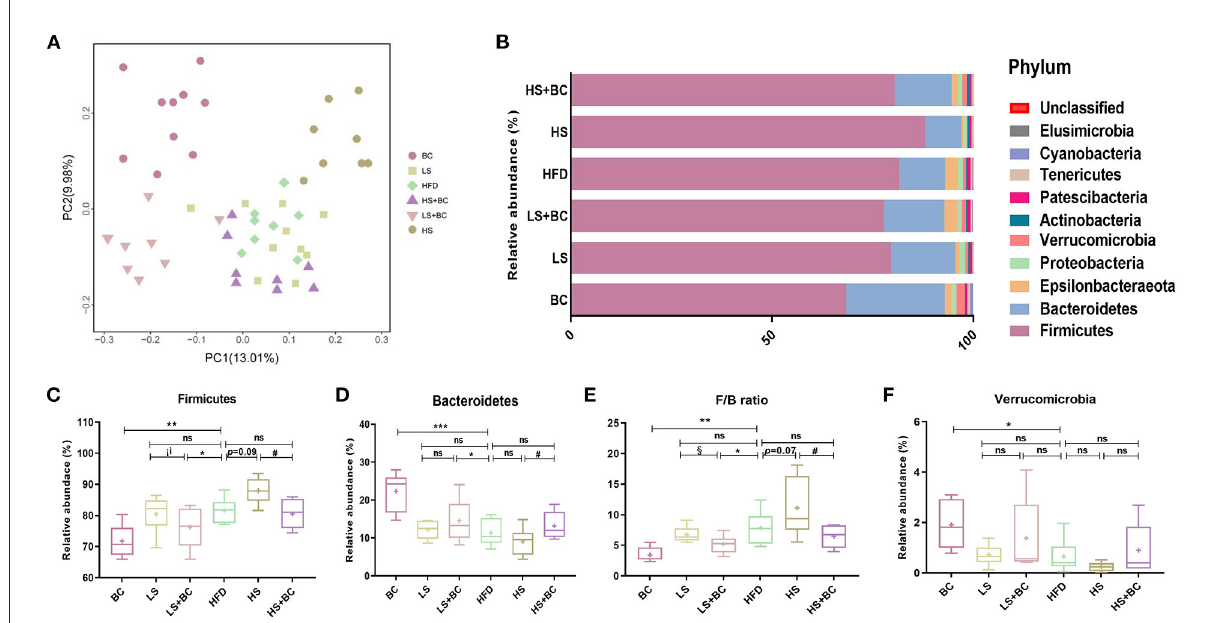
FIGURE2 Effect of BCPs treatment on gut microbiota structure of phylum level in HFD-induced obese rats. (A) Principal coordinates analysis (PCoA) of gut microbiota between the six groups, (B) compositional change at the phylum level, (C–F) the relative abundance of Firmicutes , Bacteroidetes , Verrucomicrobia and F/B ratio in the six groups. Values are means ± SEMs. * p < 0.05, ** p < 0.01 and *** p < 0.001 when comparing other groups with HFD group, # p < 0.05, ## p < 0.01, ### p < 0.001 when comparing HS group with HS + BC group, § p < 0.05, §§ p < 0.01, §§§ p < 0.001 when comparing LS group with LS + BC